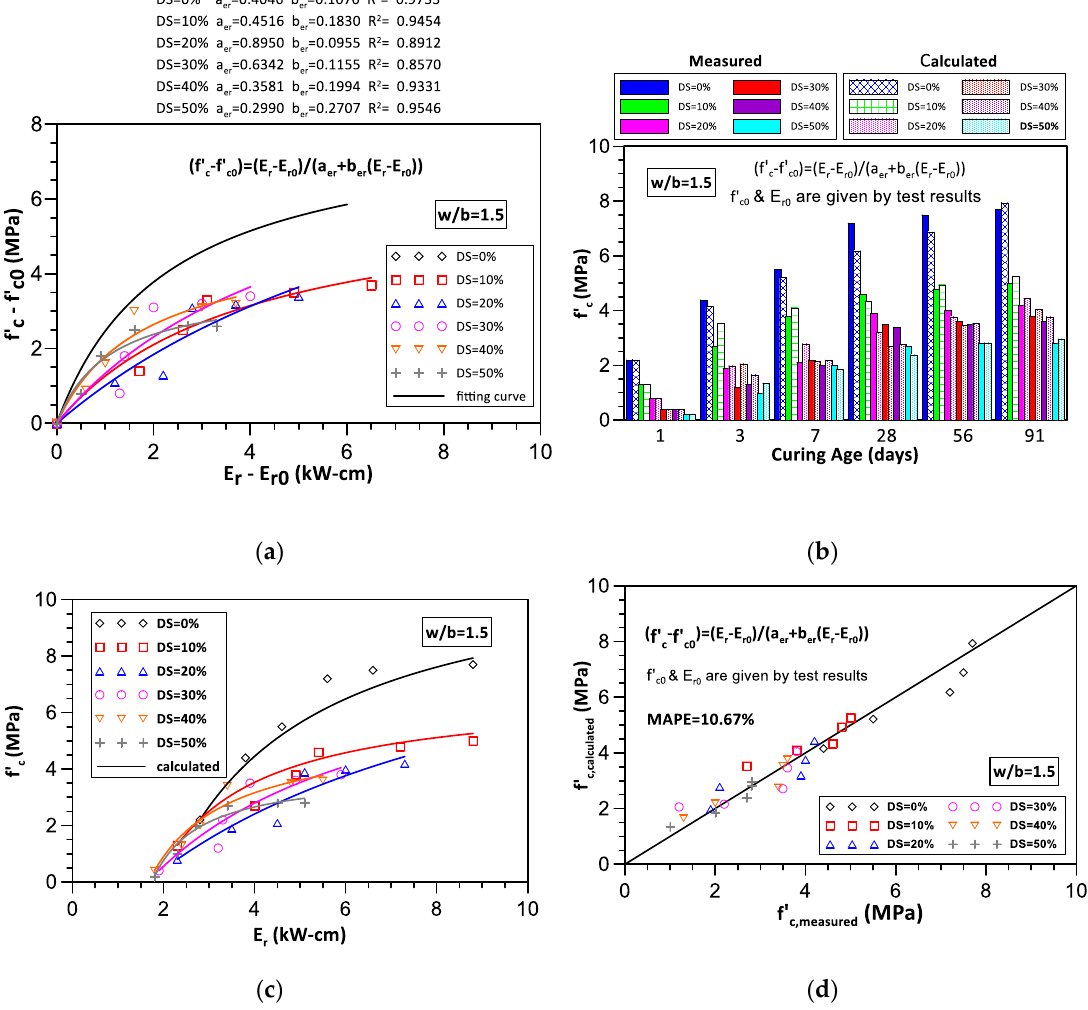
Figure 18. ( a ) Comparison of the predicted analysis and test results for the relationship between the compressive strength and surface resistivity (by curve graph). ( b ) Comparison of the predicted analysis and test results for the relationship between the compressive strength and surface resistivity (by histogram). ( c ) Comparison of the predicted analysis and test results for the relationship between the compressive strength and surface resistivity (hyperbolic function model). ( d ) MAPE value by applying the predicted analysis of the compressive strength and surface resistivity (hyperbolic function model).